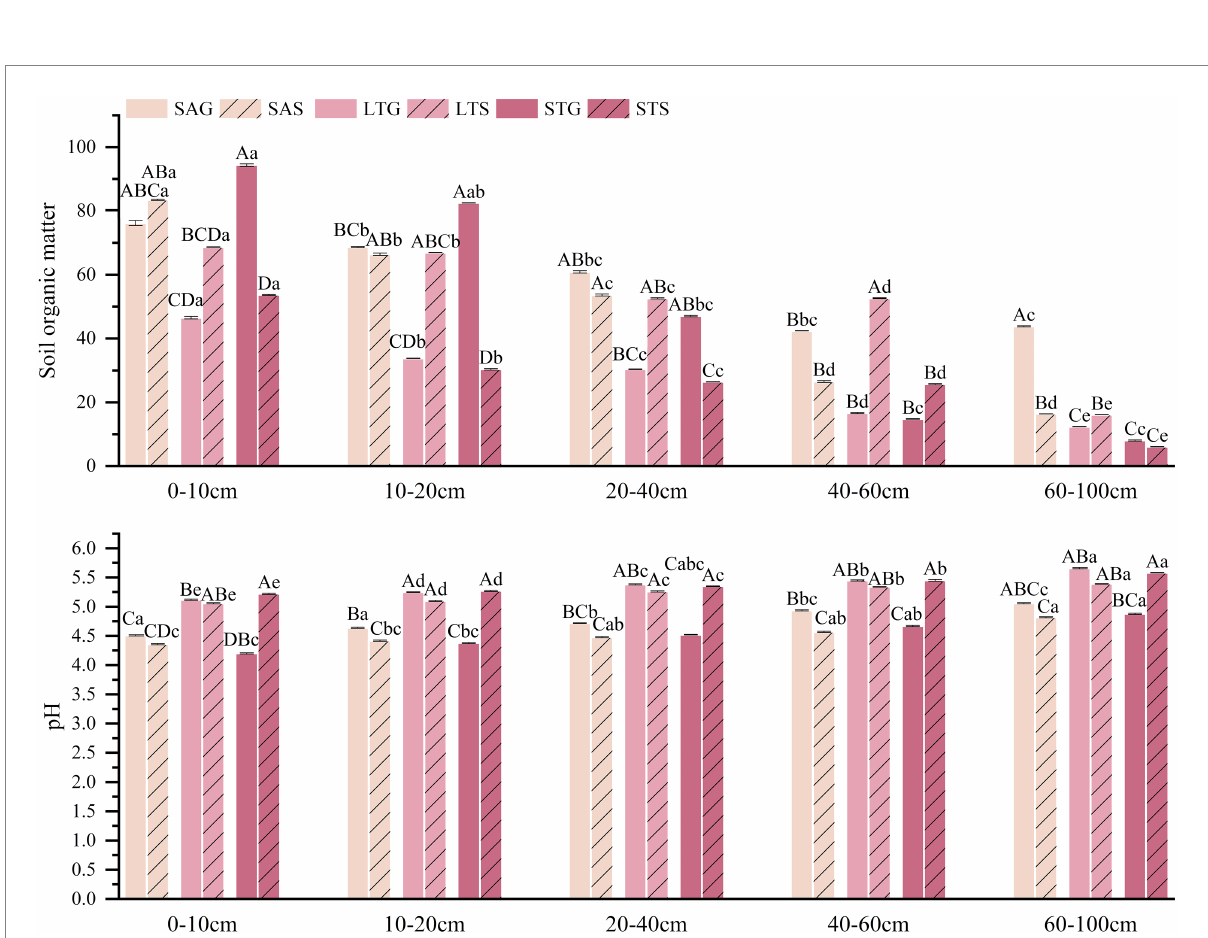
FIGURE 2 Characteristics of soil pH and SOC in the 0–100 cm soil profile under three shrub-encroached grasslands. SAS, shrub of SA; SAG, grassland of SA; LTS, shrub of LT; LTG, grassland of LT; STS, shrub of ST; STG, grassland of ST. Different lowercase letters indicates significant differences between different soil depths within the same patch at the 0.05 level ( p < 0.05), and different uppercase letters indicate significant differences between different patch types at the 0.05 level ( p < 0.05) for the same soil depth. The following figures are the